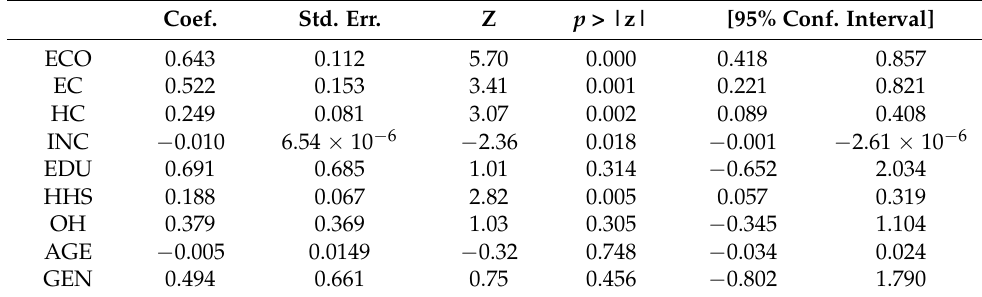
Table 6. Generalized Least Square (GLS). Coef. Std.